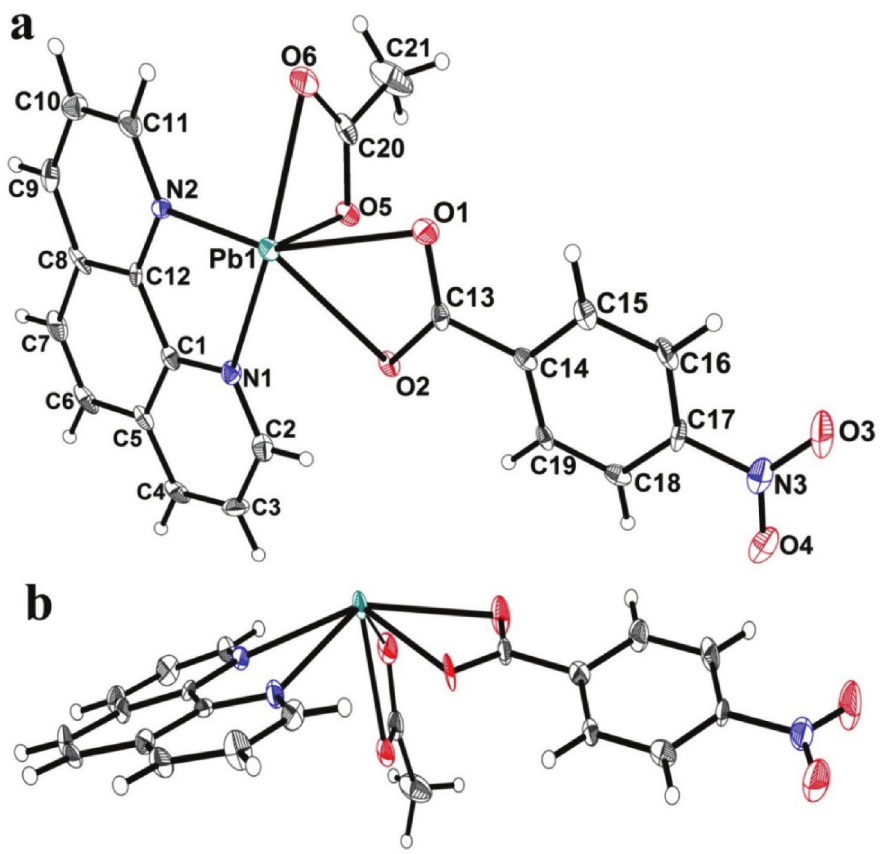
Figure 1: The molecular structure of complex at 50% ellipsoids for non-hydrogen atoms.